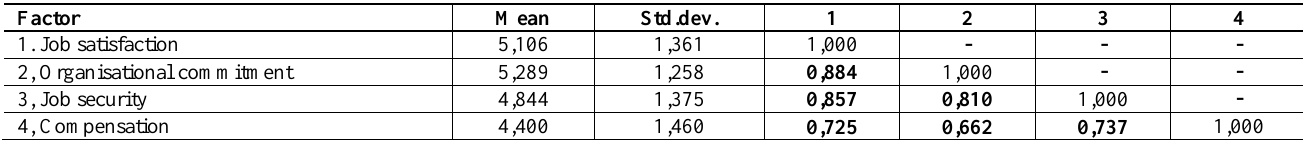
Table 8: Descriptive statistics and correlations between factors Factor Mean